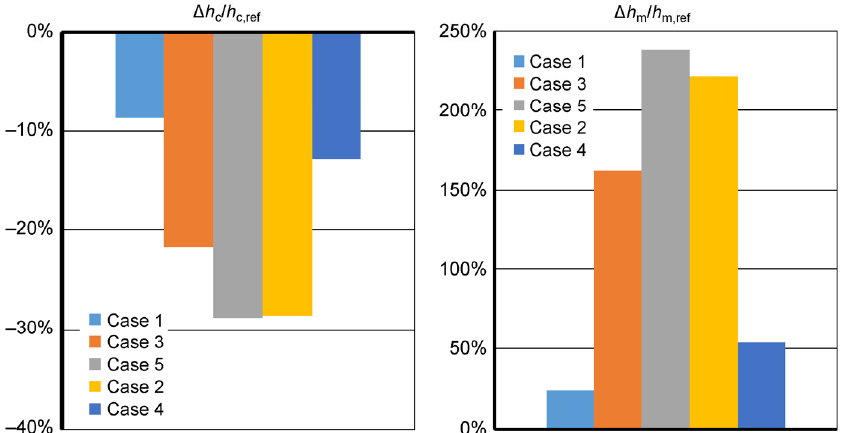
Fig. 7 Relative deviations given by the Chittenden et al. [8] analytical formulae on h c (left) and h m (right) for the 5 elliptical reference cases in a slender configuration defined by k =